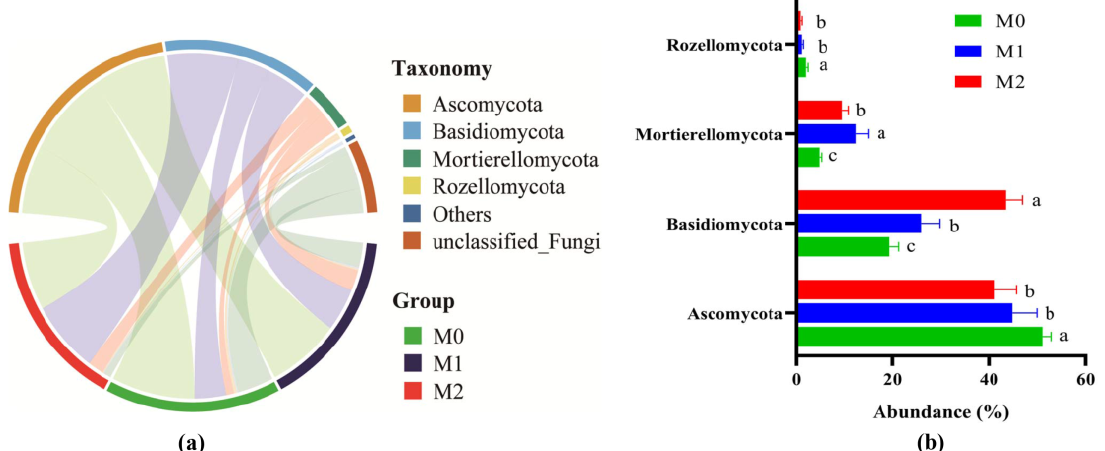
Figure 1. Characterization of the soil fungal community in soil samples from the three different management practices. ( a ) Venn diagrams of soil fungal OTUs; Fungal phyla with average relative abundance < 1% were merged and indicated as ‘Others’. ( b ) Comparative analysis for the composition of dominant fungal phyla. Different letters indicate significant variation among the treatments according to one-way ANOVA (LSD, p ≤ 0.05, n = 6).